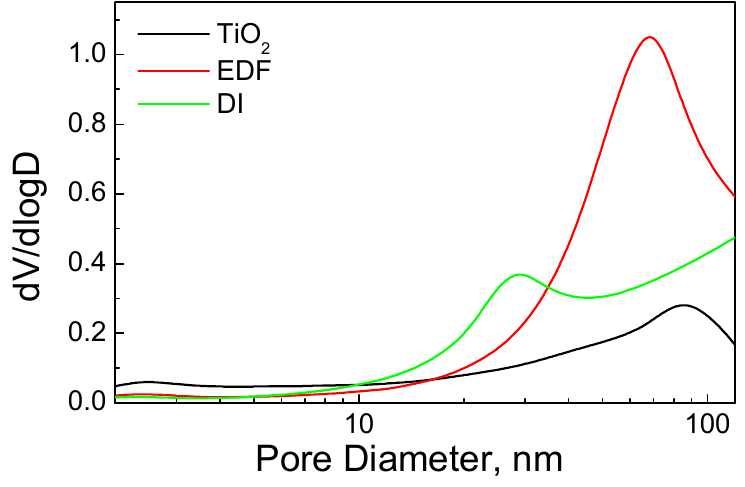
Figure 3. Pore volume distribution of the calcined samples and pure TiO 2 .